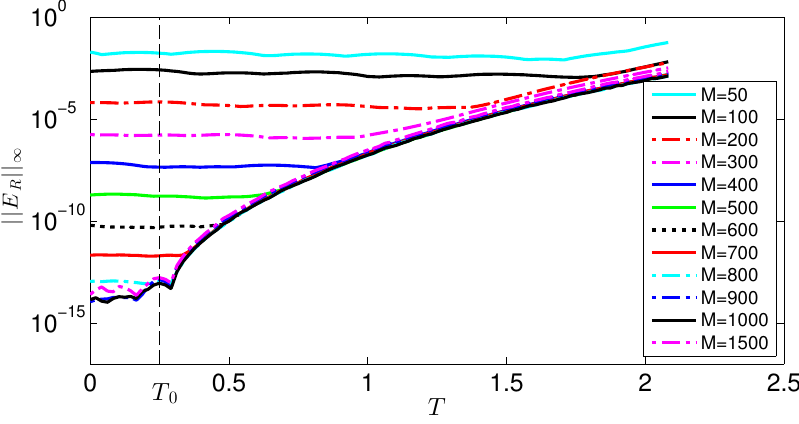
|| as a function of T in the four-pole R ∞ = 0 . 25 0